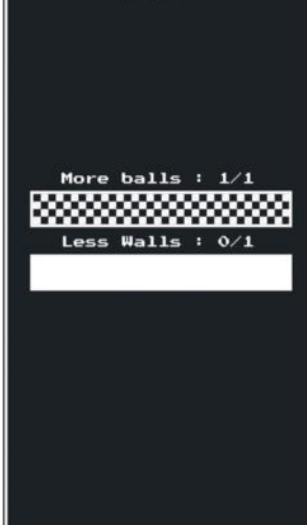
Figure 3. Page with the number of voters per choice.